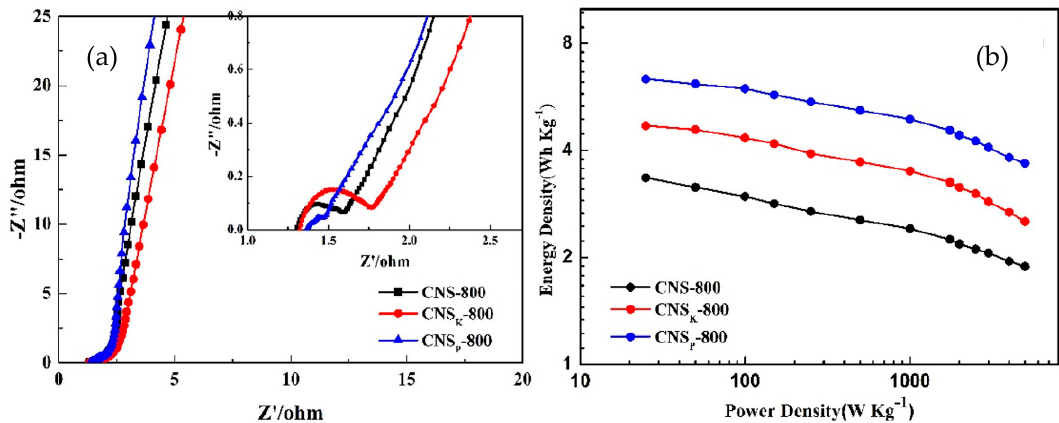
Figure 10. Electrochemical performance of carbon aerogel without chemical activation (CNS-800), with activation of potassium hydroxyl (CNSK-800) and activation of phosphorus (CNSP-800) in a two-electrode system in 1 M H 2 SO 4 : Nyquist graphs ( a ), Ragone graphs ( b ). Reprinted from [107] with permission from Elsevier.